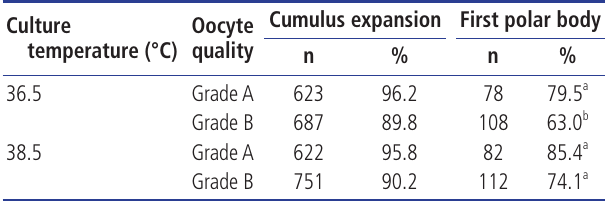
Table 1. Percentage of bovine oocytes with cumulus expansion and first polar body extrusion, matured in vitro either at 36.5°C or 38.5°C